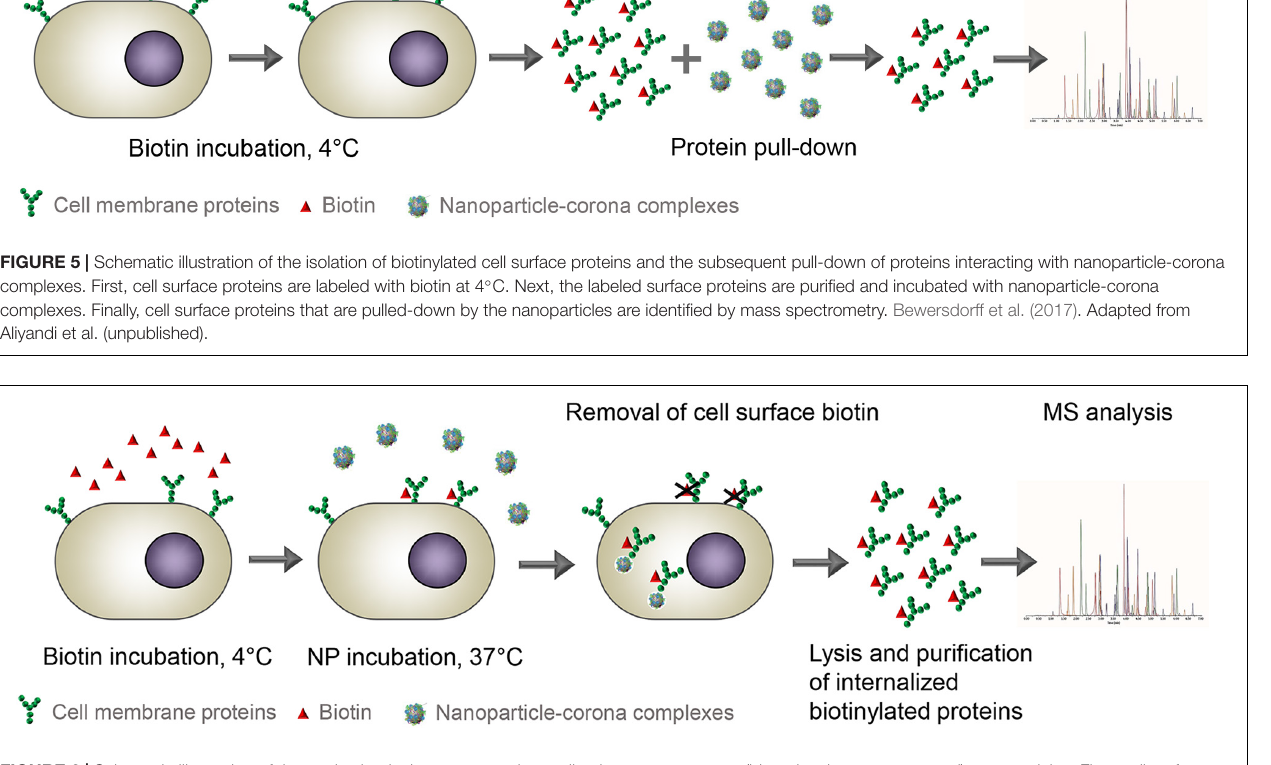
FIGURE 6 | Schematic illustration of the method to isolate receptors internalized upon exposure to (biomolecular corona-coated) nanoparticles. First, cell surface proteins are labeled with biotin at 4 ◦ C. Next, the cells are incubated with nanoparticle-corona complexes at 37 ◦ C for a certain period of time to allow nanoparticle internalization. Then, the cell surface biotin is removed, and finally, labeled proteins that are internalized by the cell upon exposure to the nanoparticles are isolated and purified, and later identified with mass spectrometry. The same method is used to identify internalized receptors in control cells not exposed to the nanoparticles, in order to select only those internalized upon exposure to the nanoparticles. Adapted from Aliyandi et al.